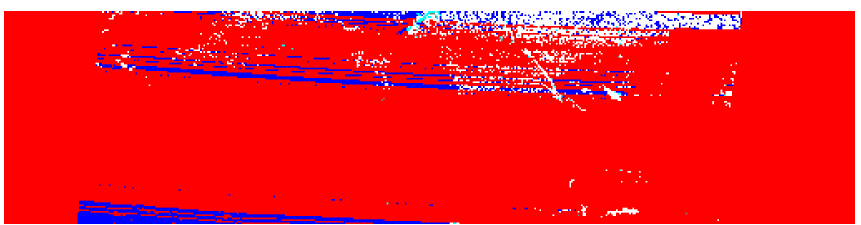
Figure 6. Map of the MISR RCCM for Path 168, Orbit 2111, Block 110 and camera BA. The linear dimensions of the mapped area and the color coding are identical to those indicated in Fig. 3.